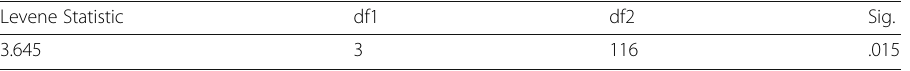
Table 3 Test of Homogeneity of Variances; Pretest of Level of Autonomy Levene Statistic df1 df2